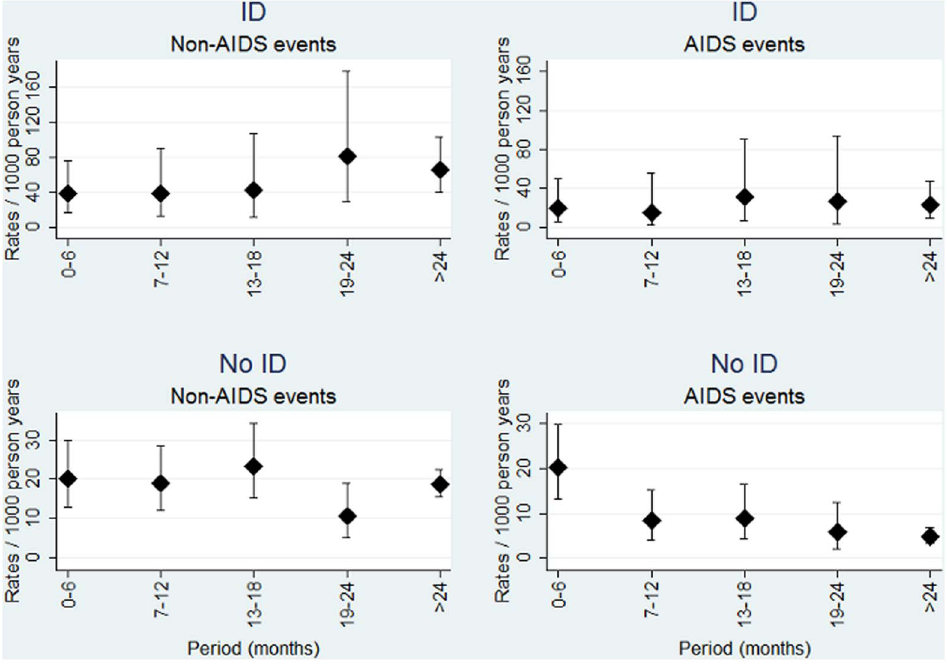
Figure 2. Rates (and 95% confidence intervals) of fatal and non-fatal non-AIDS and AIDS in patients with and without immuno- virological discordance